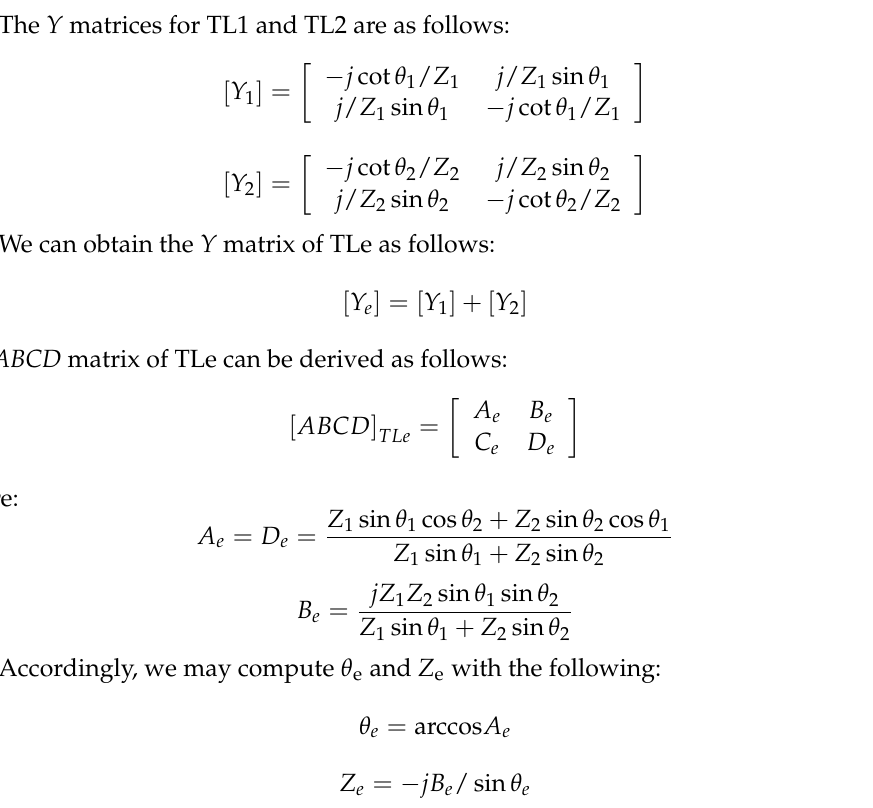
Figure 4. Two parallel transmission lines can be equivalent to a new transmission line.